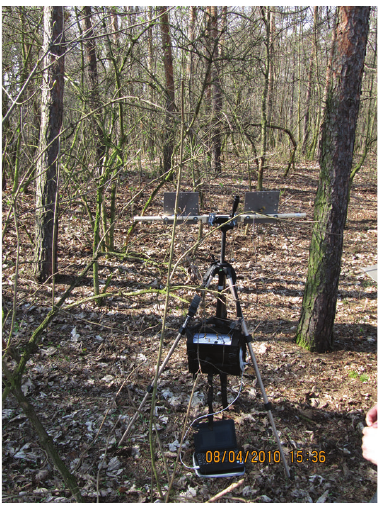
Figure 2: Receiver antennas and